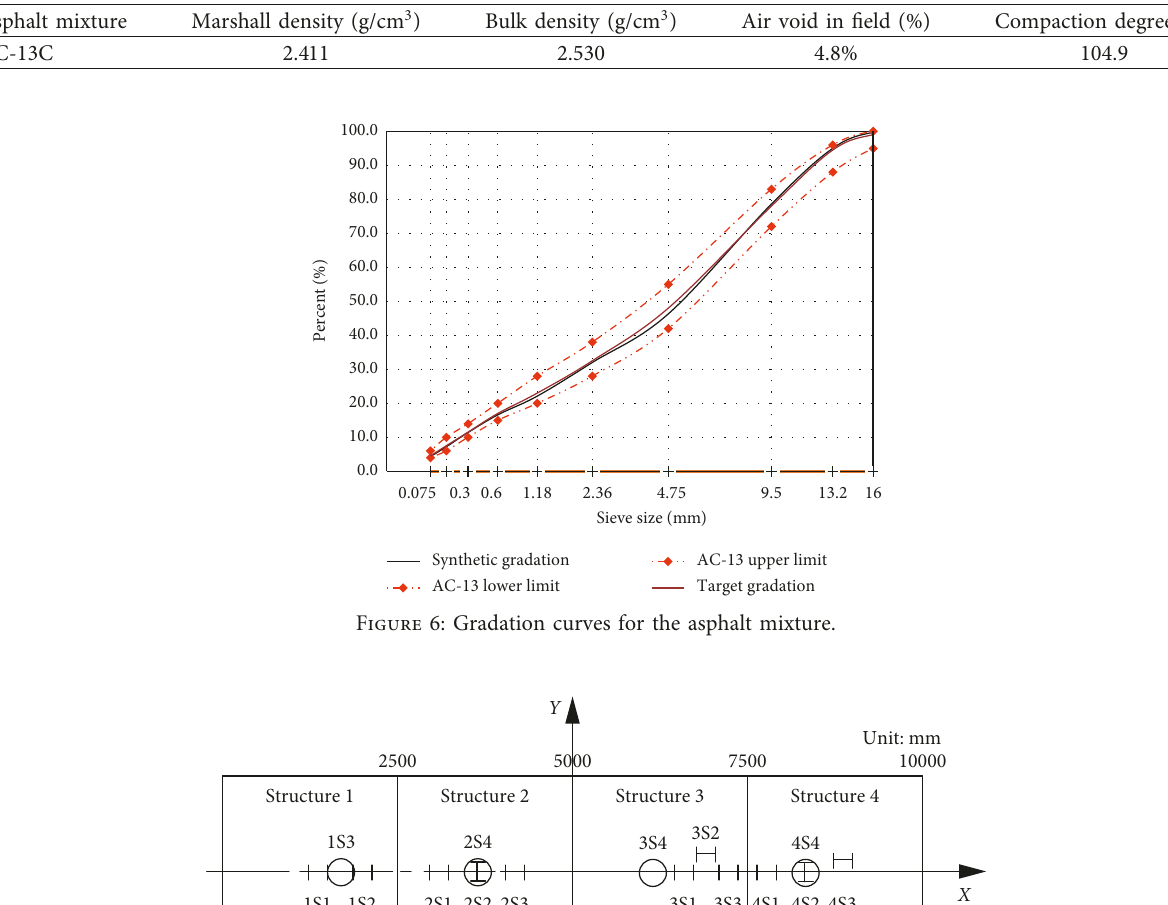
Table 4: Density, air void in field, and compaction degree.